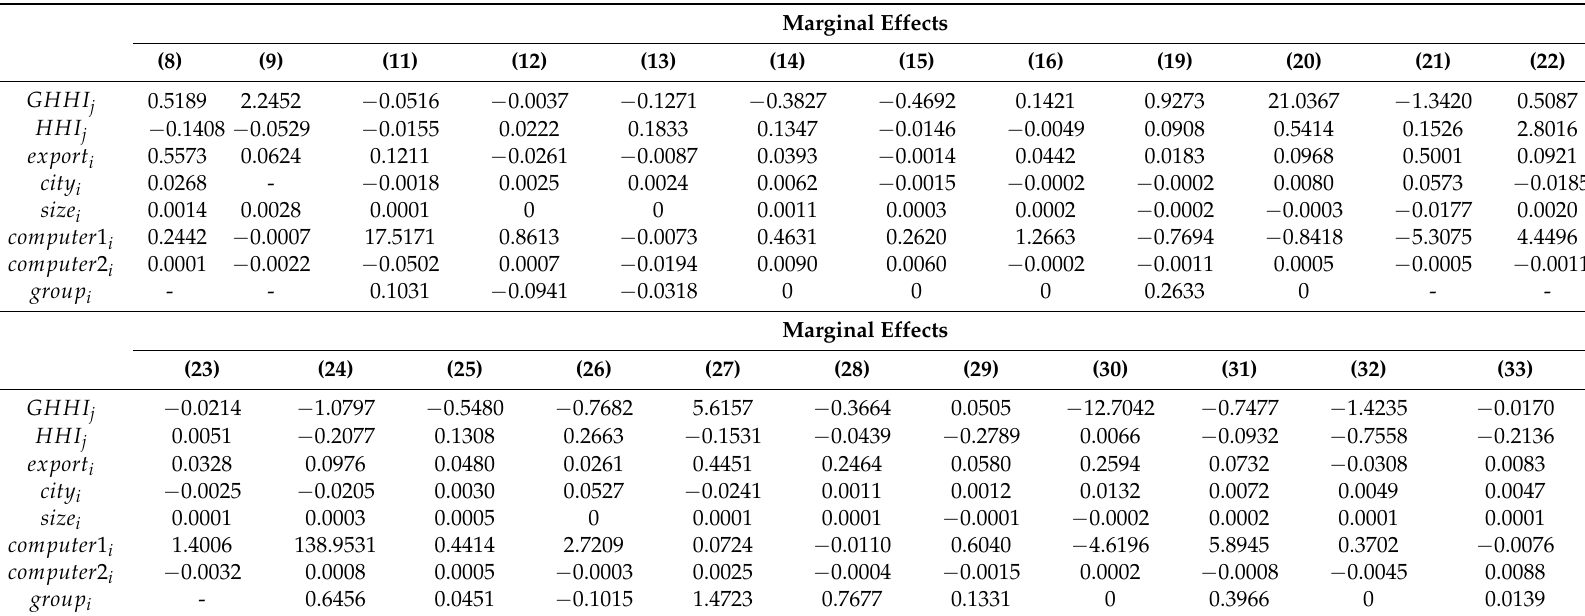
Table 9. Marginal effect of the internet intensity (with HHI) for two digit industries (unit: